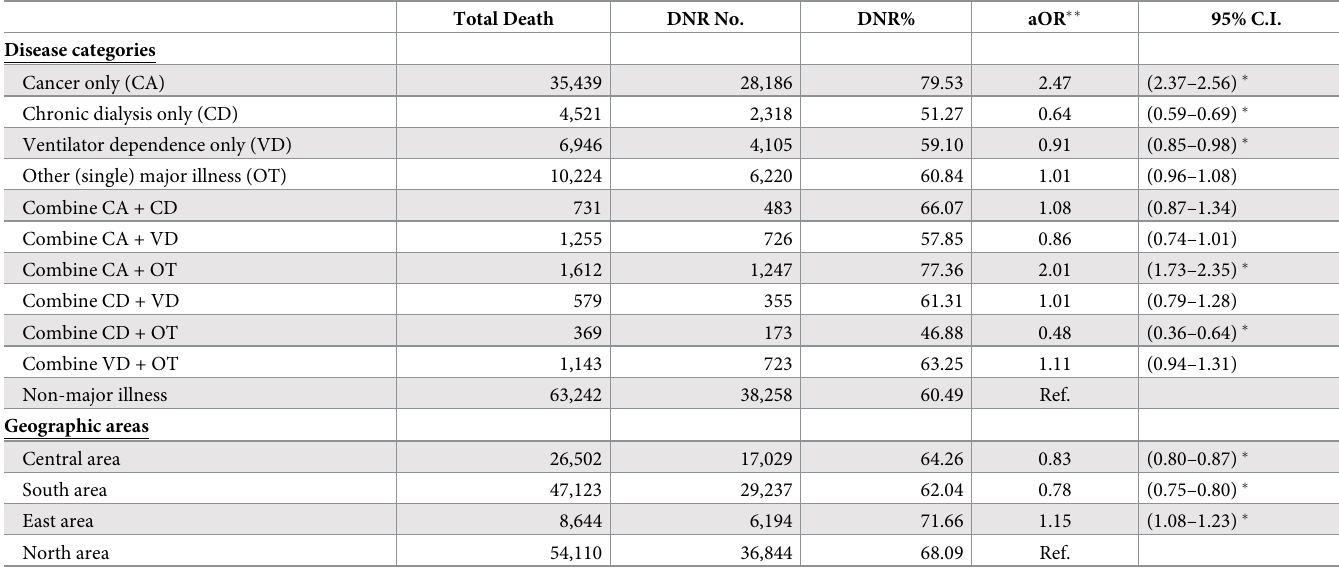
Table 2. Adjusted odds ratios (aOR) of do-not-resuscitate (DNR) rates among different and combined major illnesses and geographic